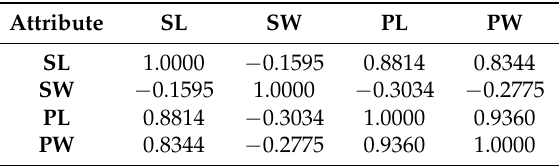
Table 1. Correlation coefficients among